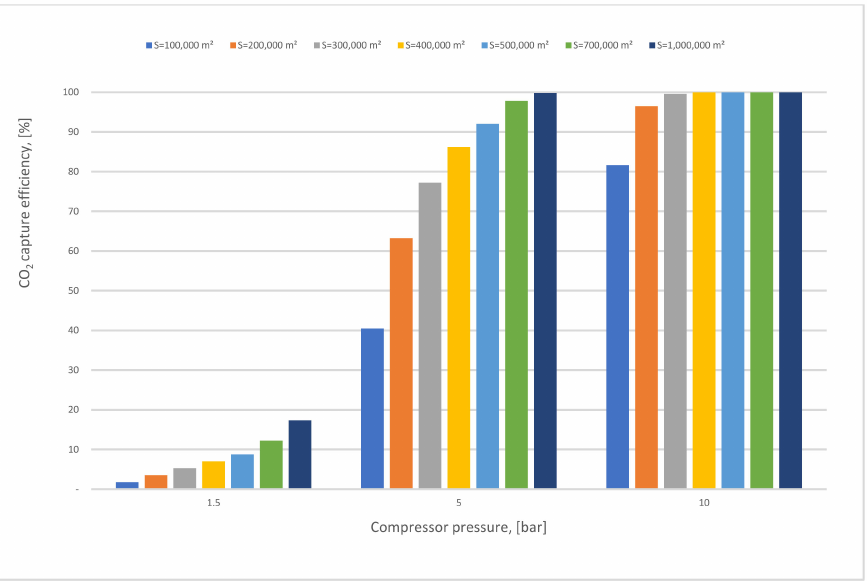
Figure 11. First membrane surface and 1st compressor pressure influence on CO 2 capture efficiency for 1-stage (case A, B) at 0.5 of vacuum pump pressure.